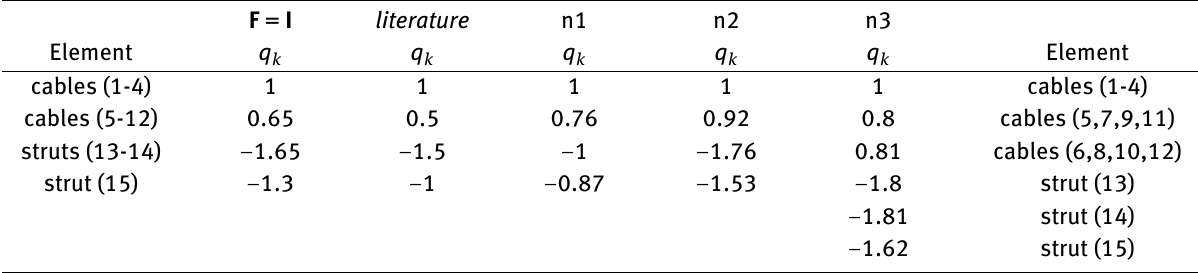
Table 9: Force densities of the elements of the Octahedral cell, normalized with respect to the force density of the first group